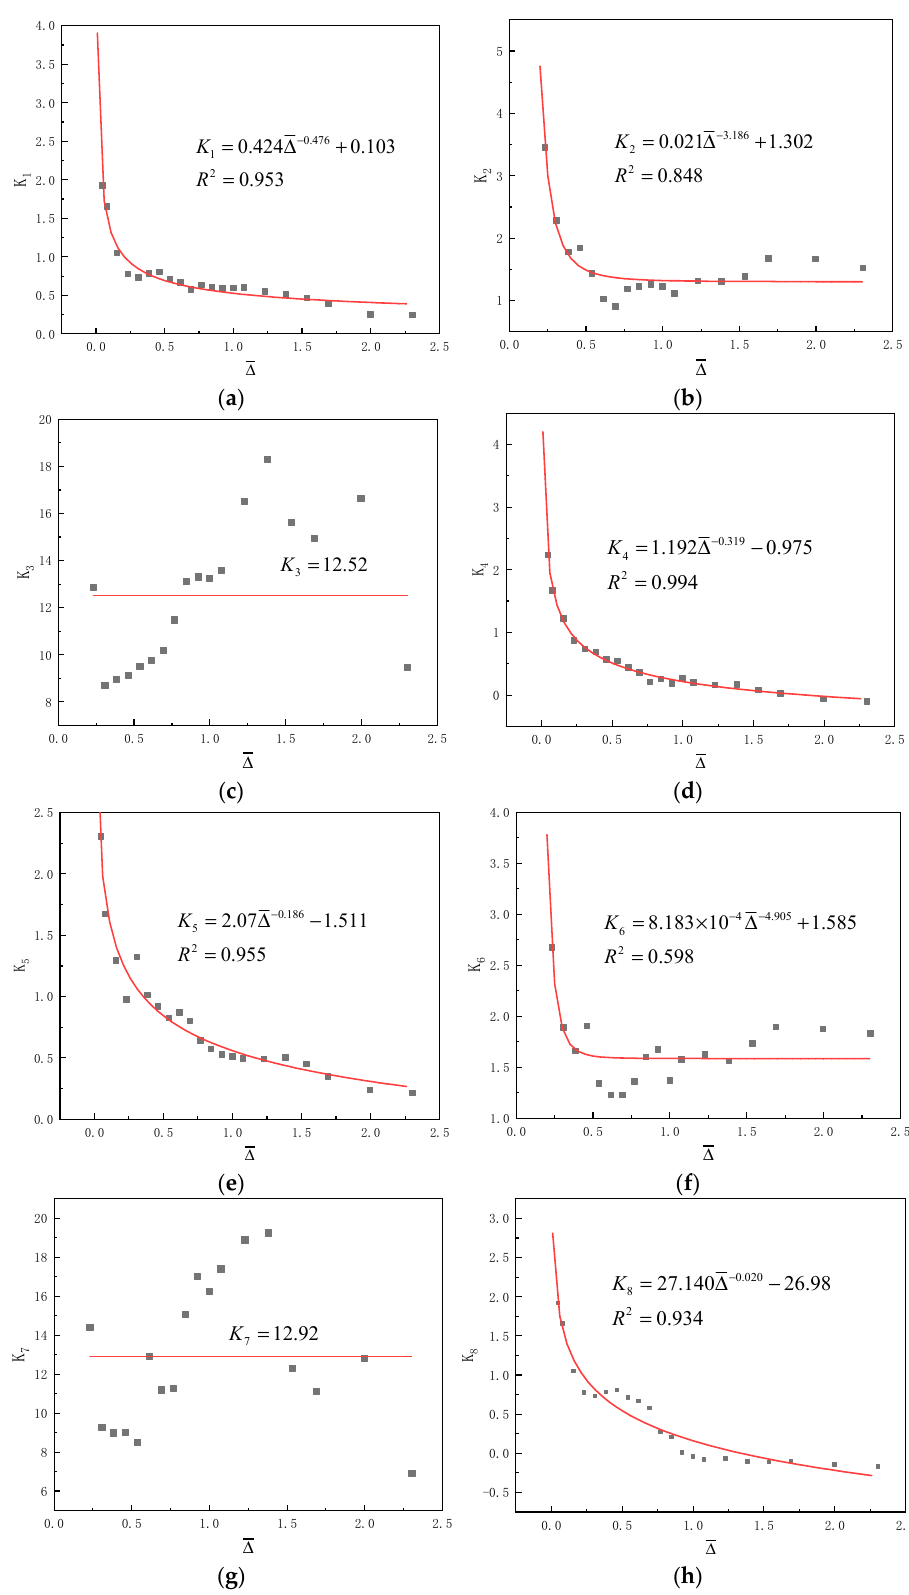
Figure 17. Stiffness degradation curves and fitting equations of the Kanchuang frame at different loading states: ( a ) K 1 ; ( b ) K 2 ; ( c ) K 3 ; ( d ) K 4 ; ( e ) K 5 ; ( f ) K 6 ; ( g ) K 7 ; ( h ) K 8